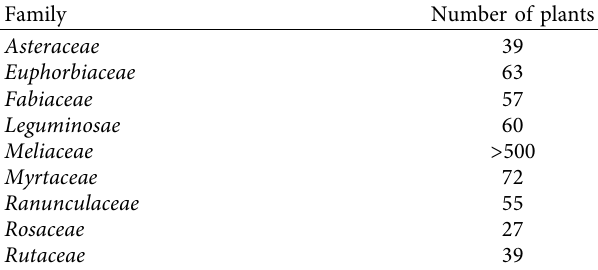
Table 2: Important plant families having plants with antifungal